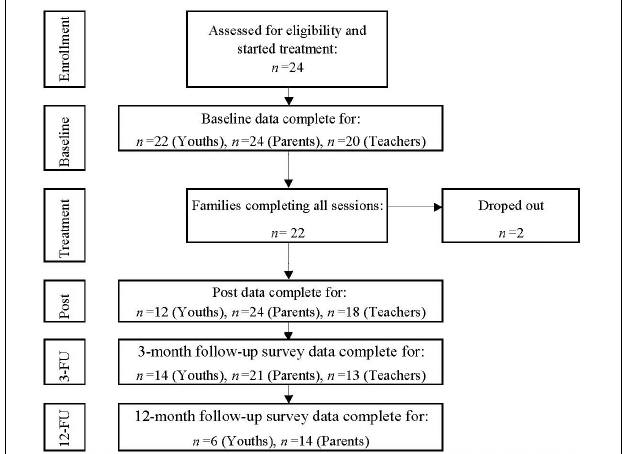
FIGURE 1 | Flow diagram of response and completion